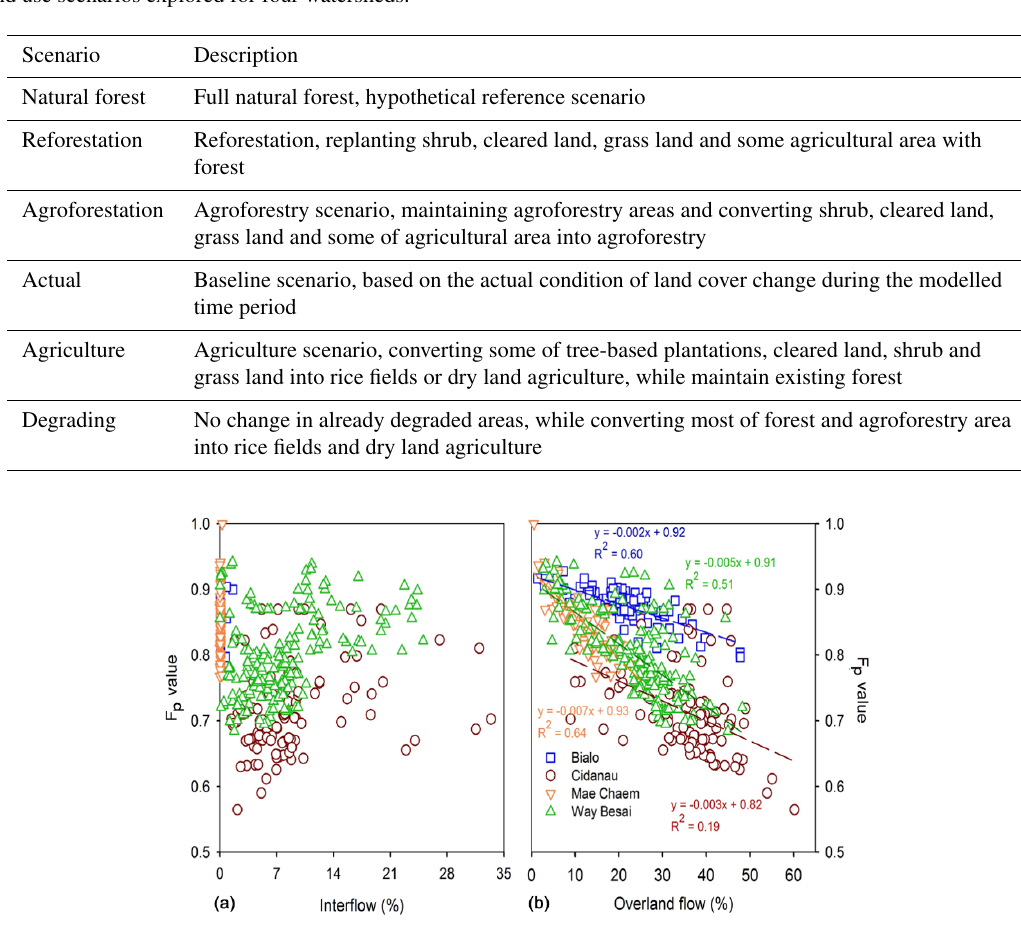
Table 4. Land use scenarios explored for four watersheds.